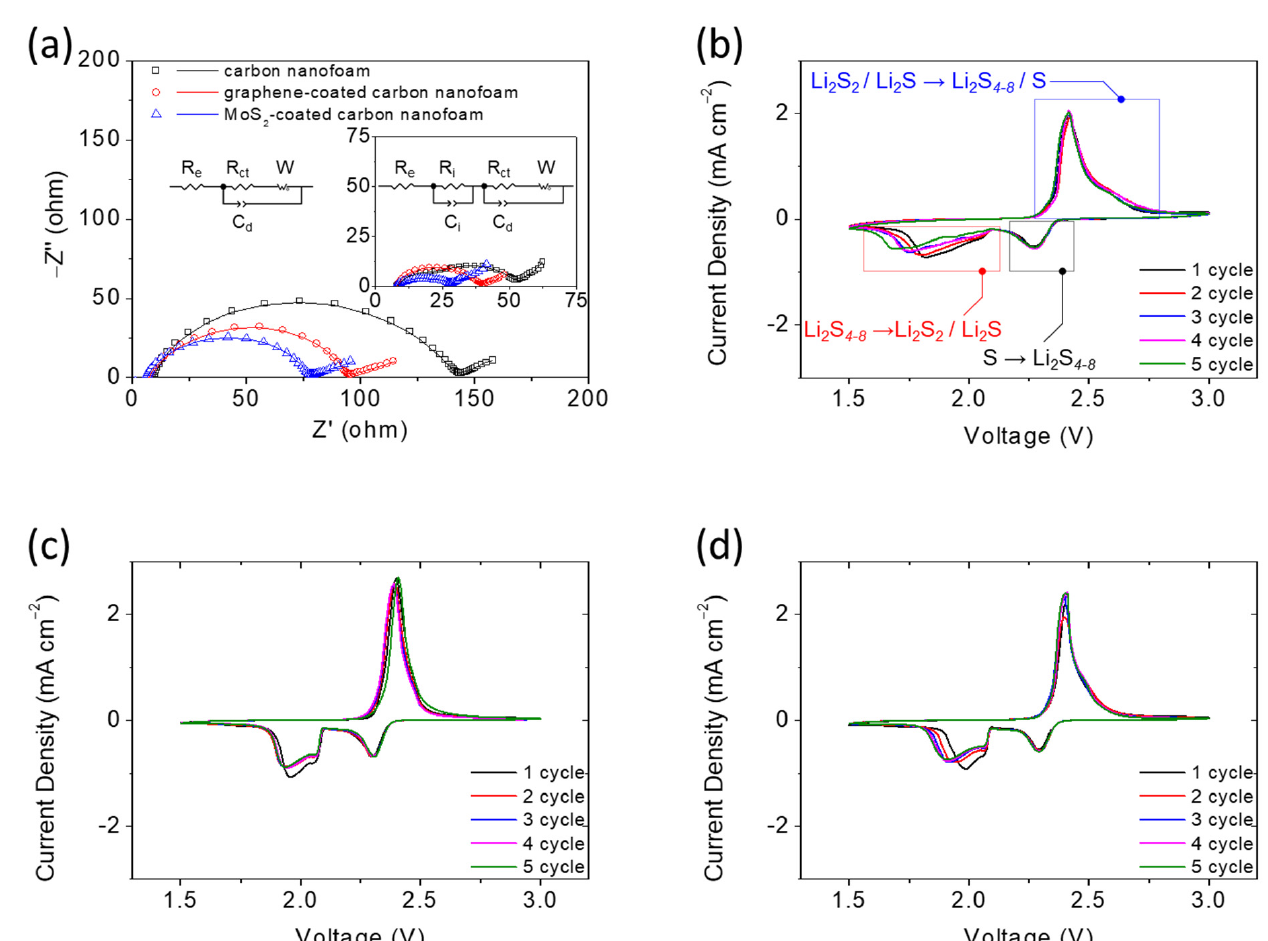
Figure 3 . Electrochemical analysis: ( a ) electrochemical impedance analysis of the high-loading sulfur cathodes with various carbon nanofoams before and after cycling (inset). The data points are the experimental impedance data, and the data curves are the fitting impedance data obtained by the equivalent circuits. Cyclic voltammograms of sulfur cathodes with ( b ) the carbon nanofoam, ( c ) the graphene-coated carbon nanofoam, and ( d ) the MoS 2 -coated carbon nanofoam at 0.02 mV s − 1 .